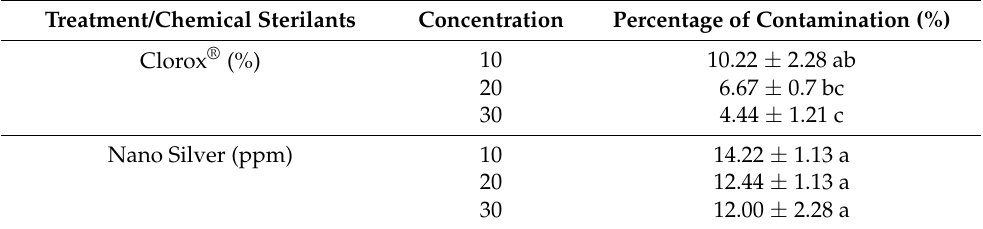
Table 1. Effect of different chemical sterilants and concentrations towards the percentage of contami- nation (%) of P. niruri on week 2 of incubation.